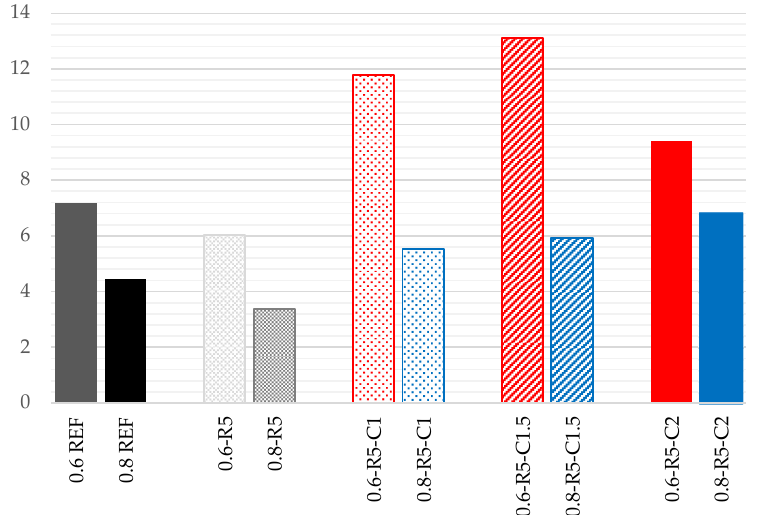
Figure 4. Results for flexural strength (MPa).